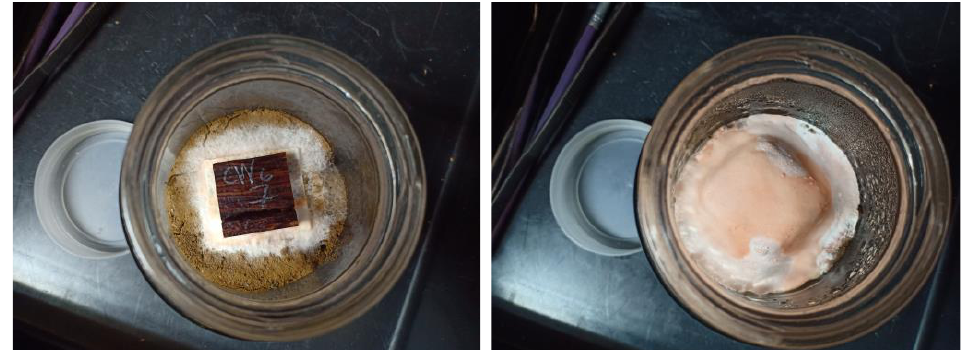
Figure 5. Fungal growth observation of the MGE plywood ( left ) and control ( right ) after 8-week exposure to white rot fungi.